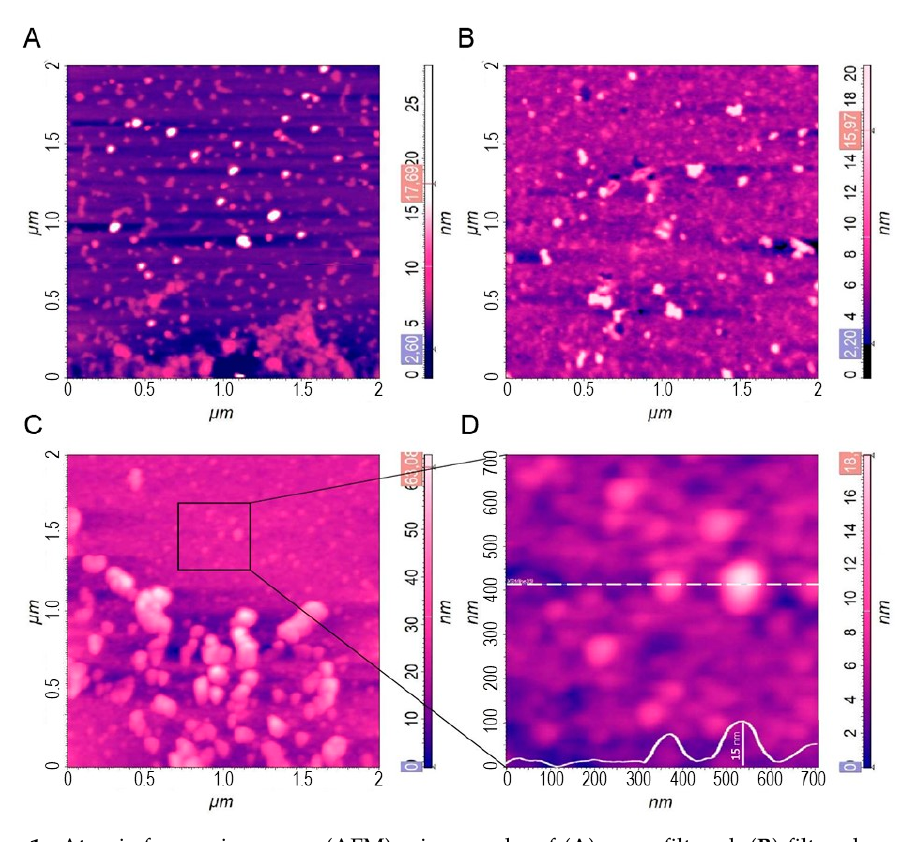
Figure 1. Atomic force microscopy (AFM) micrographs of ( A ) an unfiltered, ( B ) filtered exosome standard, ( C ) an extracellular vesicle (EV) isolate from a blood plasma sample, and ( D ) magnification of the area indicated in C.